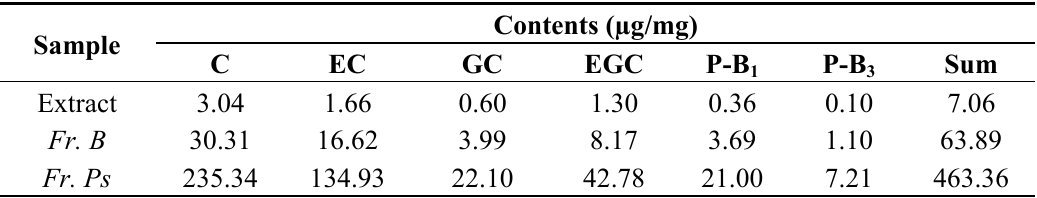
Table 7. Analytical results for the catechins and procyanidins contents in the fractions and the extract.